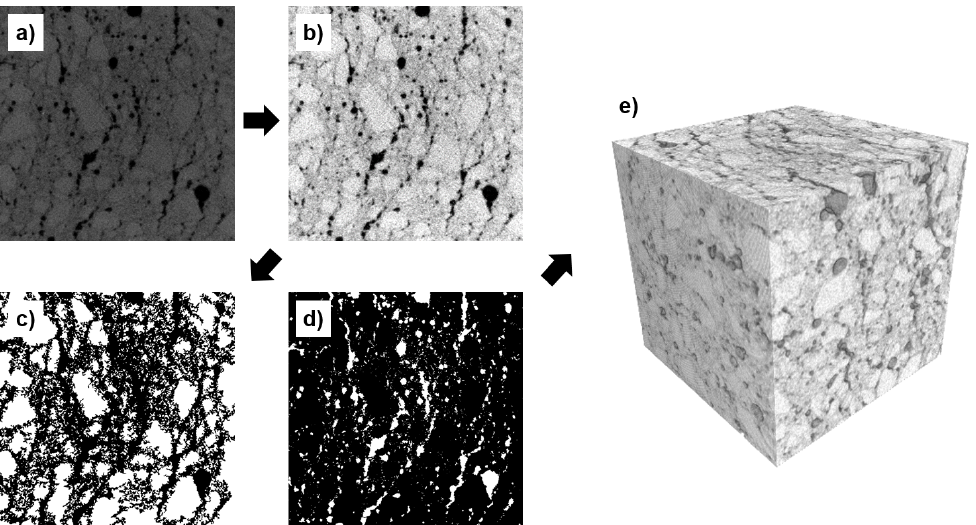
Figure 4. µ -CT imaging process to investigate pore and solid characteristics: ( a ) original µ -CT image; ( b ) contrasted image; ( c ) binarized image for aggregates; ( d ) binarized image for pores; ( e ) 3D µ -CT image (Note: in ( c ) and ( d ), the white regions represent aggregates ( c ) and pores ( d ) while the black is a background.)